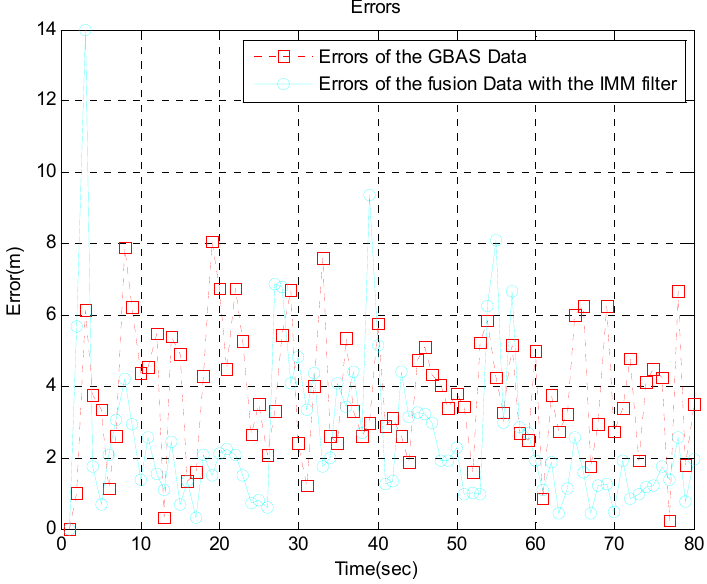
Figure 5. Errors between GBAS data and fusion data with the IMM filter near the airport.